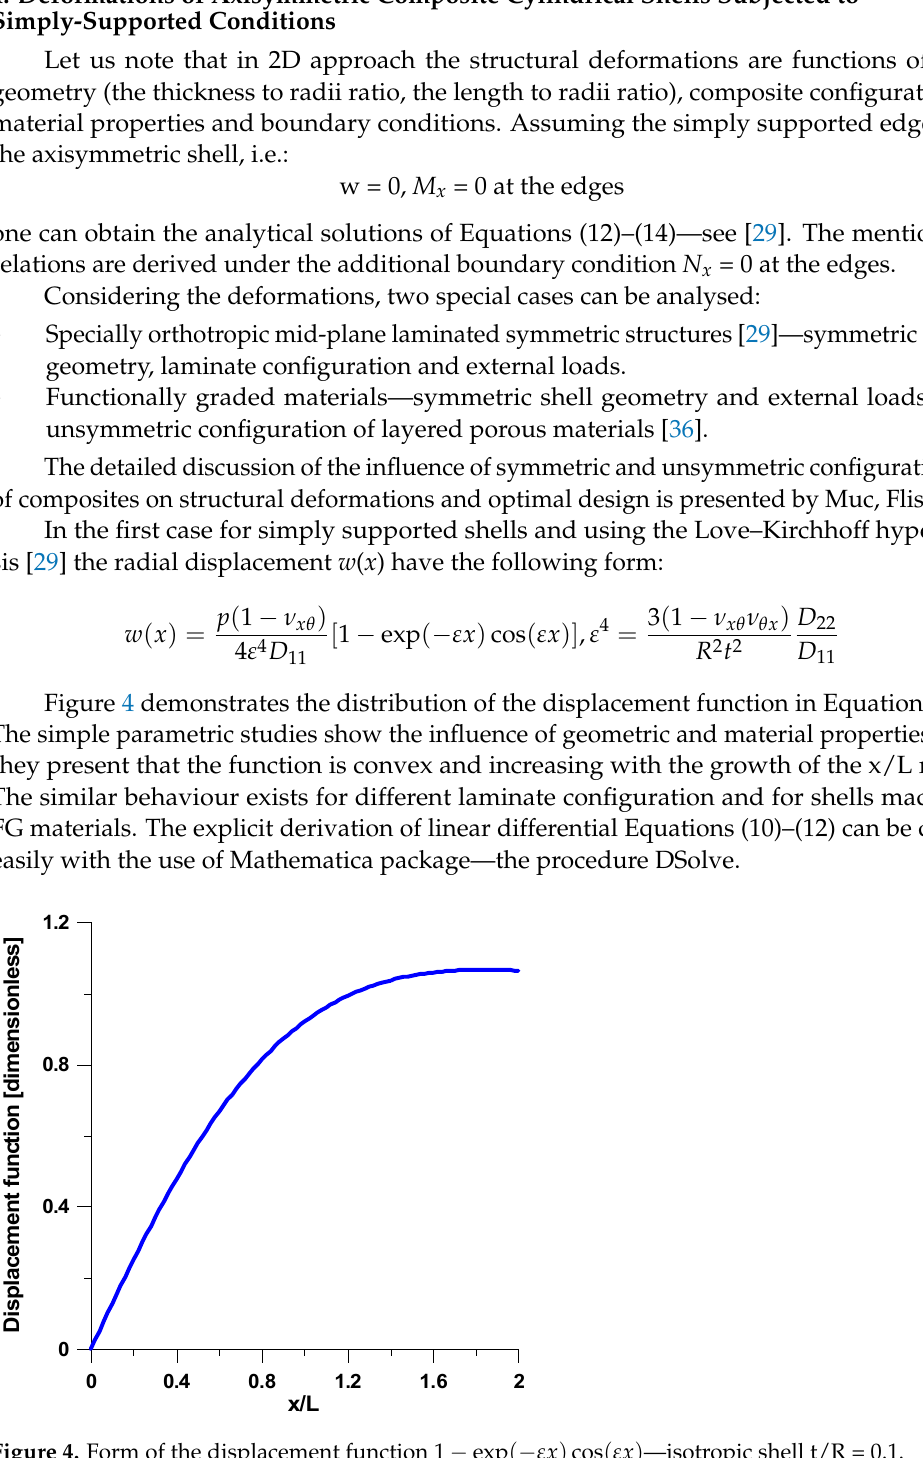
Figure 4. Form of the displacement function 1 − exp ( − ε x ) cos ( ε x ) —isotropic shell t/R =